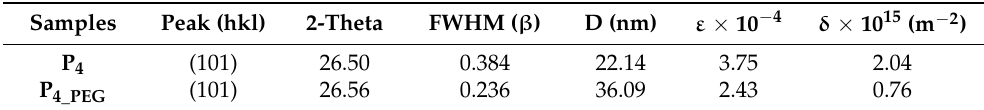
Table 3. Crystallite sizes, strain, and dislocation density values of P 4 and P 4_PEG thin films from XRD results.